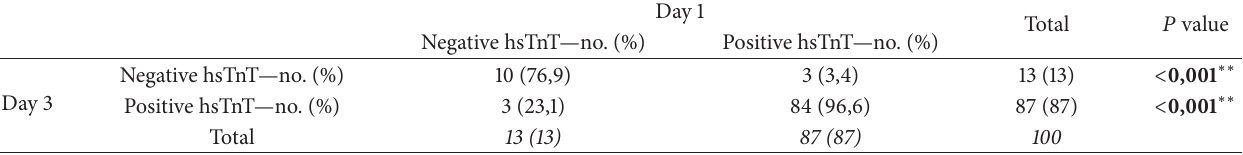
Table 3: Comparison of hsTnT values below (negative) and above (positive) the 99th percentile ( ≥ 0,014ng/mL). Day 1 Total 𝑃 value Negative hsTnT—no. (%)